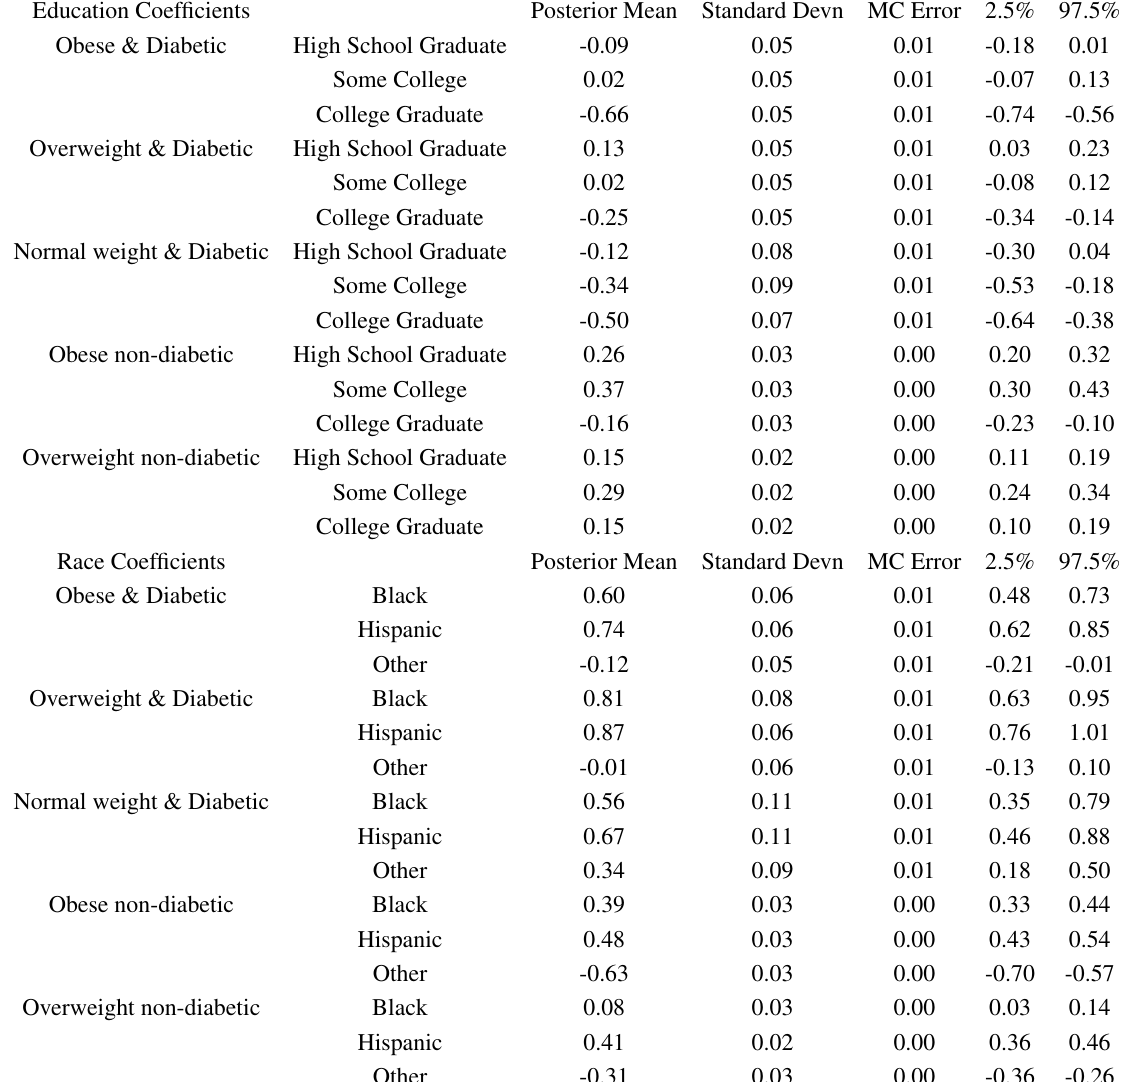
Table 7 . Effects of county predictors by diabetes-weight category, model